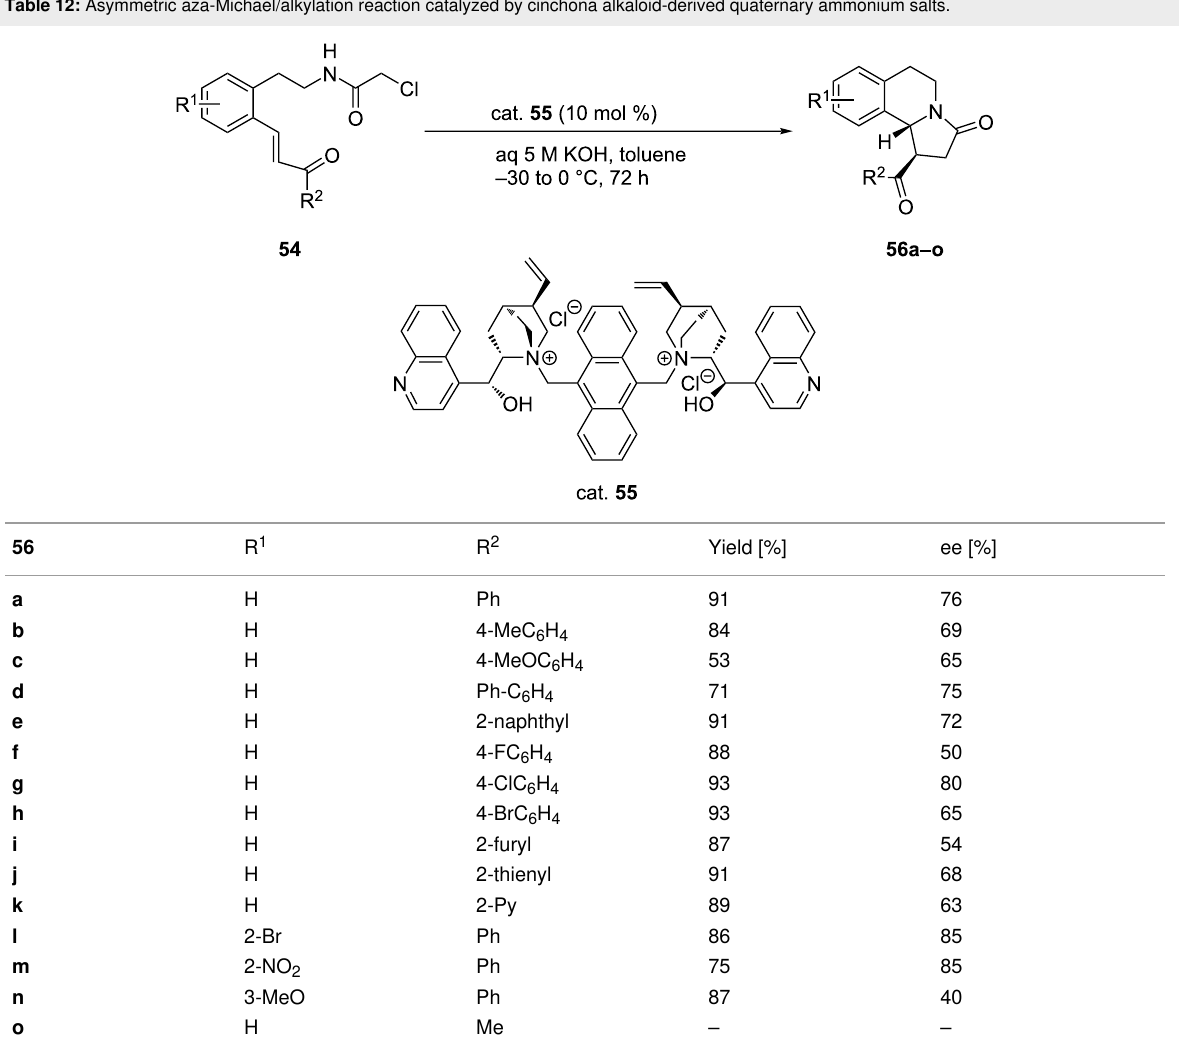
Table 11: Asymmetric aza-Michael addition reaction catalyzed by phase-transfer catalyst. (continued) b